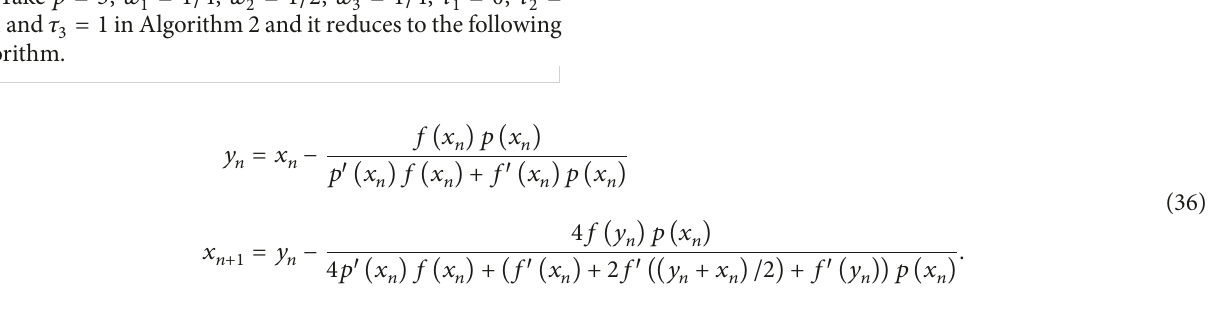
Algorithm 8. The iterative scheme which will compute the